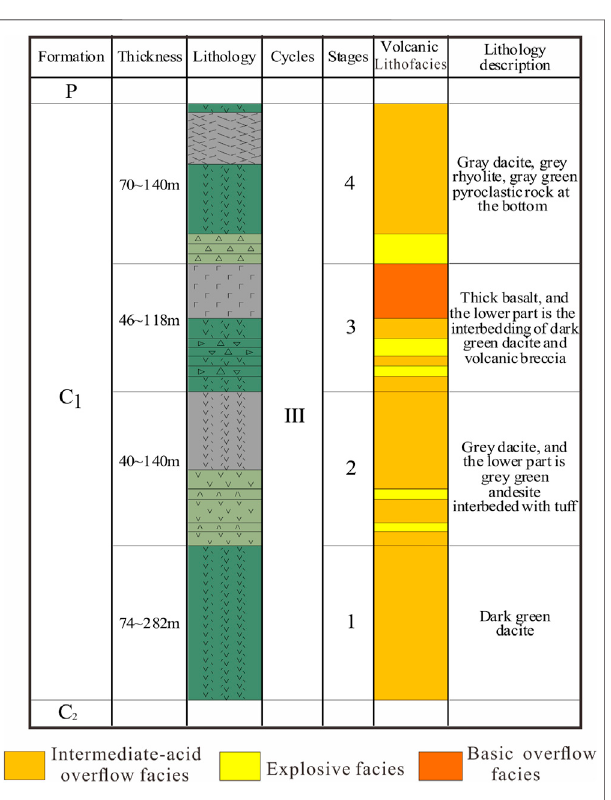
Frontiers in Earth Science |